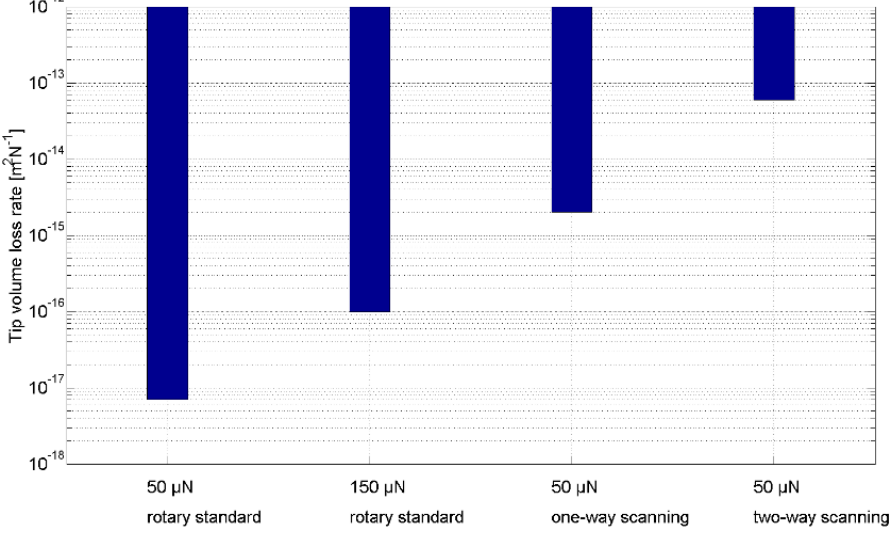
Figure 13. Tip volume loss rate under different experimental conditions.